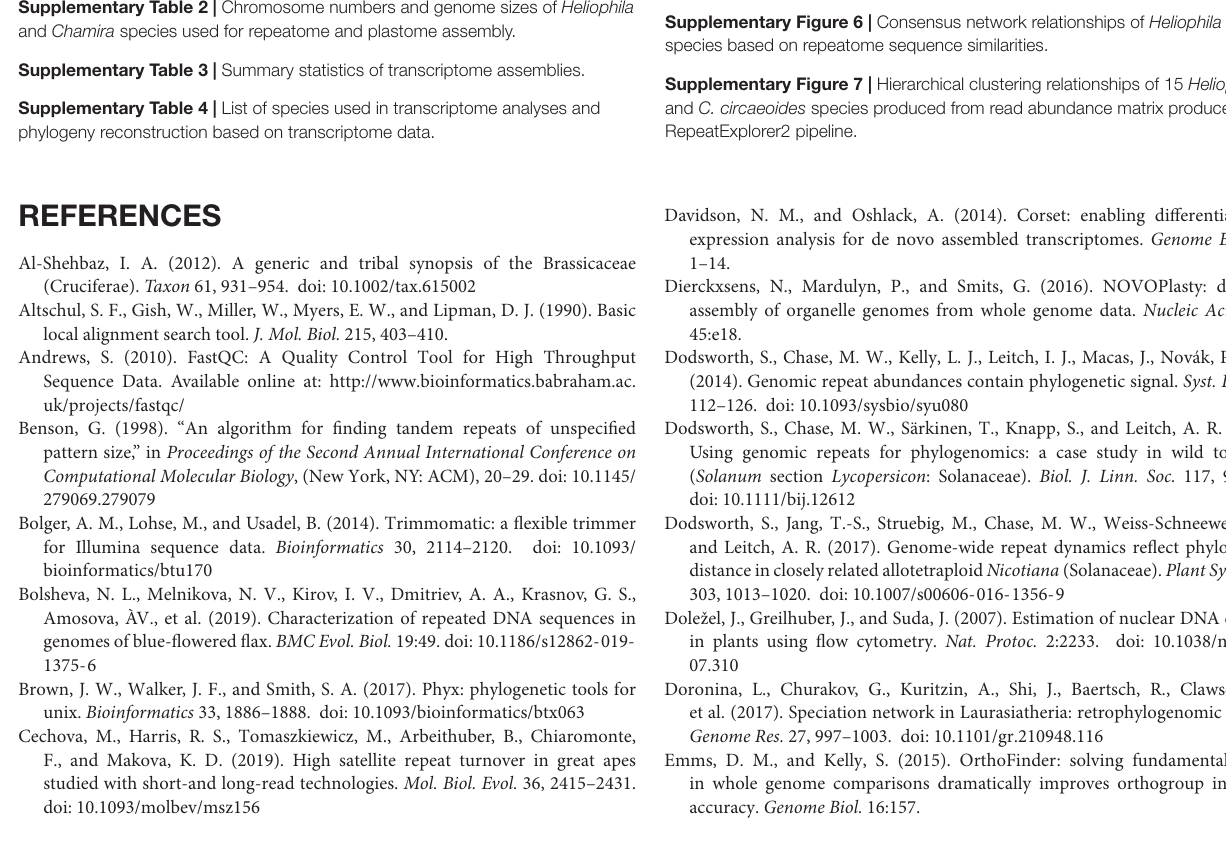
Supplementary Table 1 | List of Heliophila and Chamira accessions used in our study. Supplementary Table 2 | Chromosome numbers and genome sizes of Heliophila and Chamira species used for repeatome and plastome assembly. Supplementary Table 3 | Summary statistics of transcriptome assemblies.